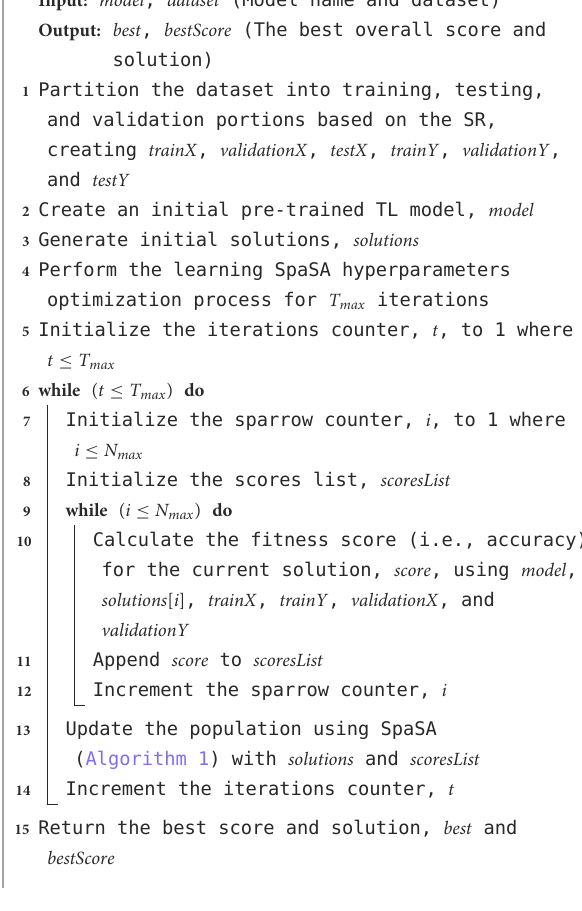
TABLE 6 The common experiments